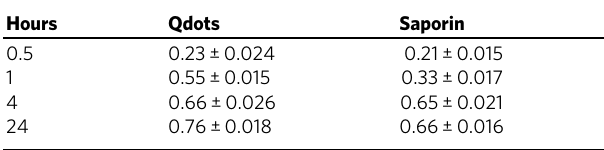
Table 3 A Subpopulation of saporin-containing vesicles do not colocalize with the